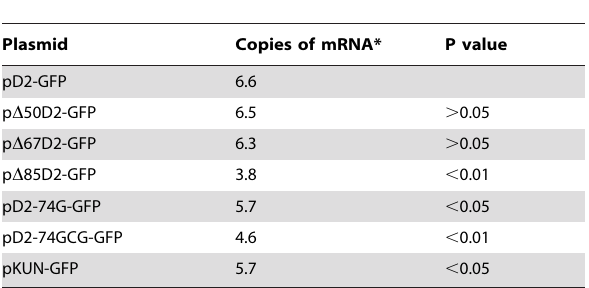
Table 1. Quantitative detection of GFP gene in total cellular RNA extracted from E. coli cells transformed with pD2-GFP, pD2-GFP mutants and